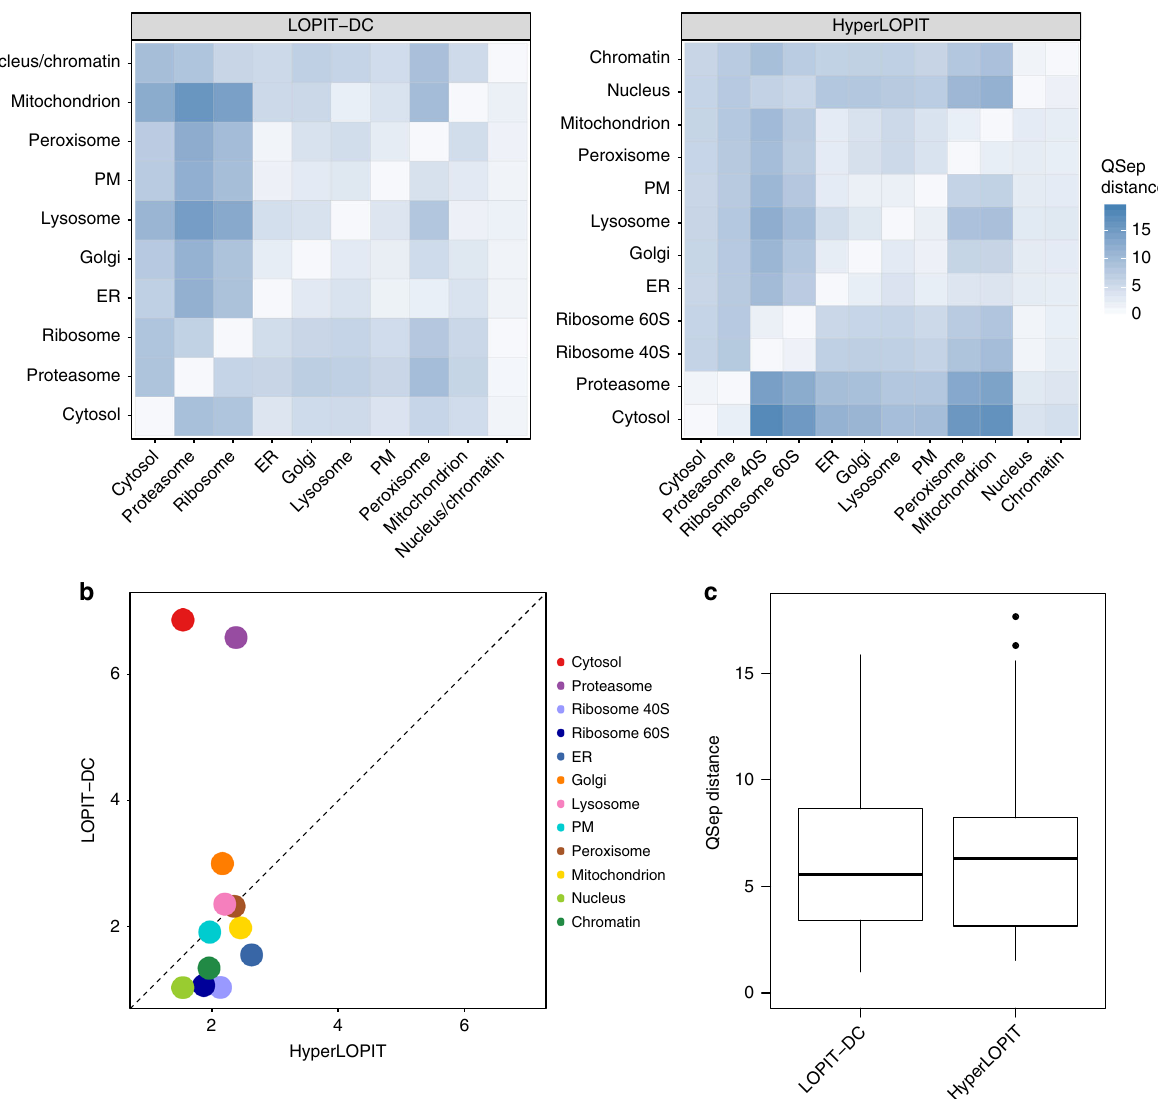
Fig. 3 LOPIT-DC provides a high-resolution map of protein subcellular localisation. a QSep distances between all pairs of compartments in the LOPIT-DC (left) and hyperLOPIT (right) data. Ten organelle classes were used in the case of the LOPIT-DC data and 12 in the case of the hyperLOPIT dataset. b Comparison between LOPIT datasets of the minimum QSep distances for each of the 12 subcellular compartments. c Overall distribution of QSep distances for the LOPIT-DC and hyperLOPIT data. For each boxplot, the line in the middle of the box is the median value, the vertical size of the box represents the interquartile range (IQR) and the whiskers represent the extremes of the data (de fi ned as those that do not exceed 1.5 × IQR from the middle of the data, and if no points exceed that distance, then the whiskers are simply the minimum and maximum